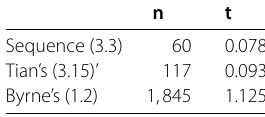
Table 1 (cid:2) = 10 –5 , P = 3, M = 3, N = 3